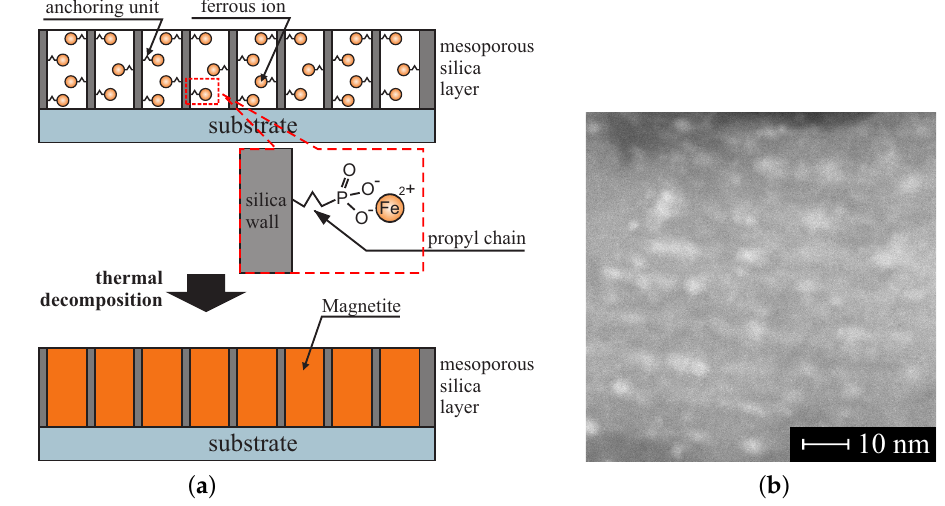
Figure 15. The general illustration the procedure of magnetite synthesis by the use of silica nanoreactors ( a ); and resulting nanoparticles of magnetite obtained inside SBA-15 (TEM image) ( b